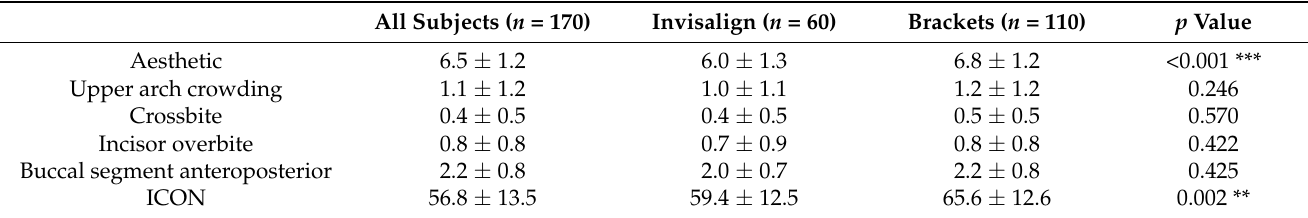
Table 7. Index of complexity outcome and need (ICON) of patients, stratified by orthodontic device (Invisalign ® or bracket) ( n =